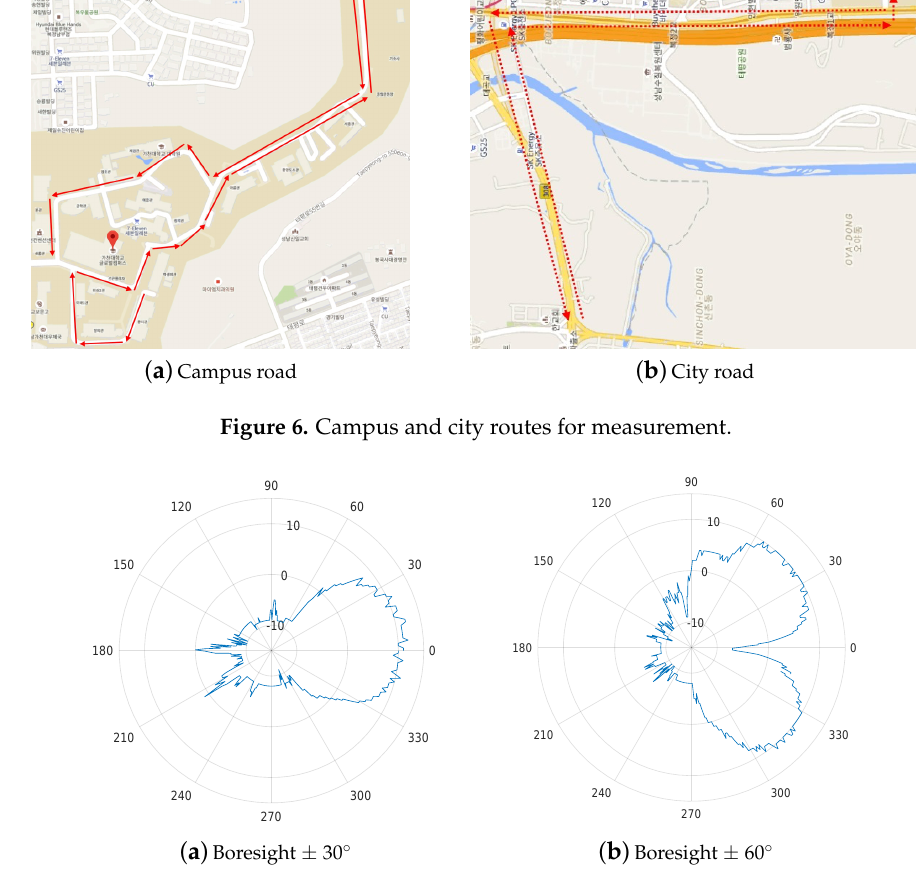
Figure 7. Measured beam patterns and